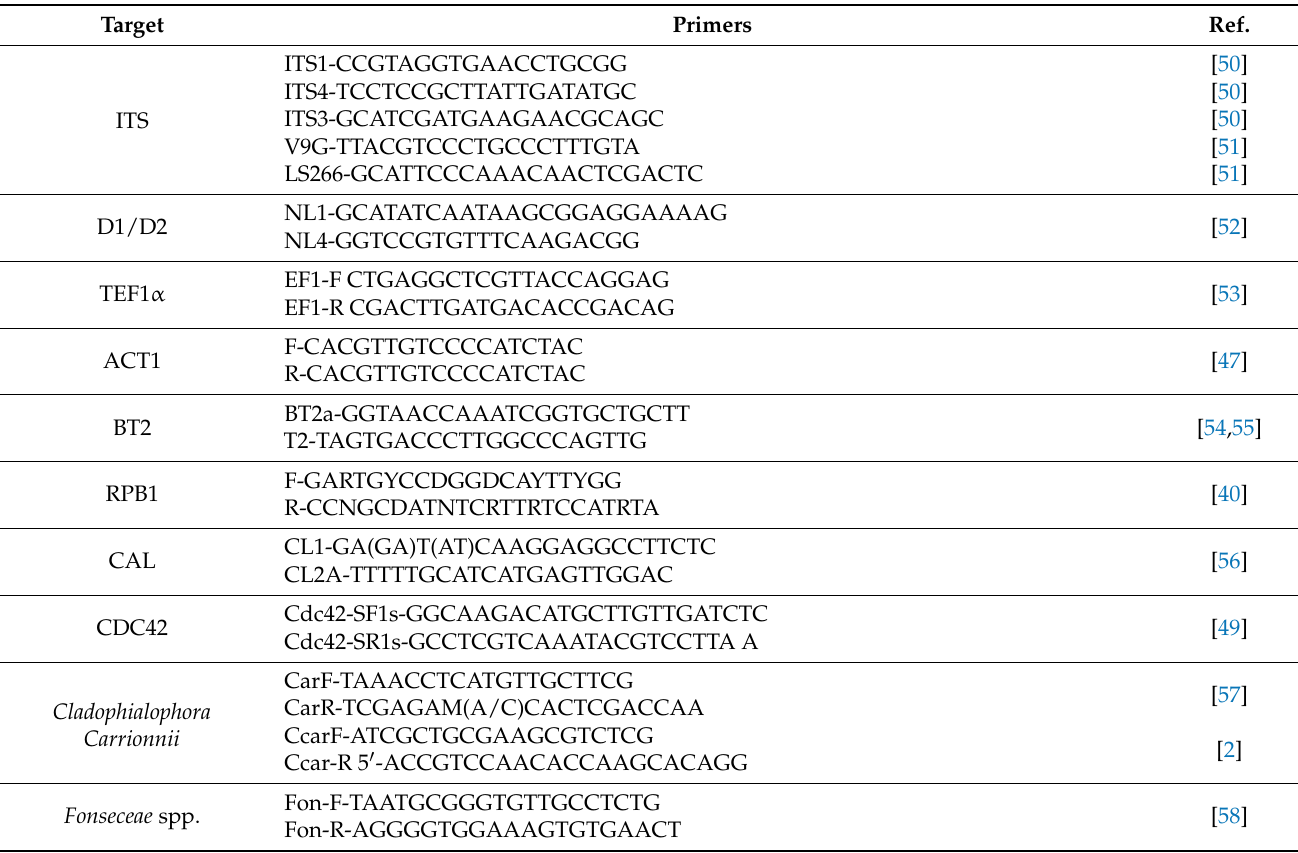
Table 2. Primer sequences cited and used for sequencing or